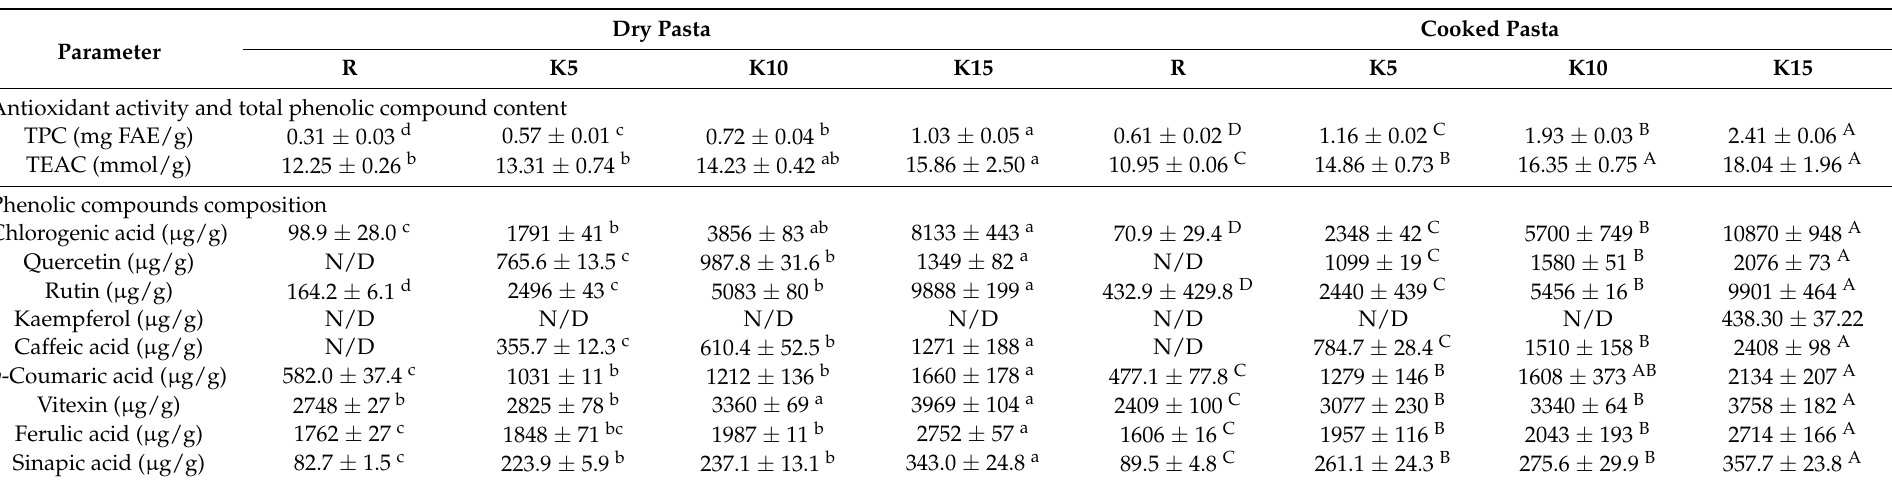
Table 6. Results of antioxidant activity and phenolic compounds composition after cooking per 1 g of dry